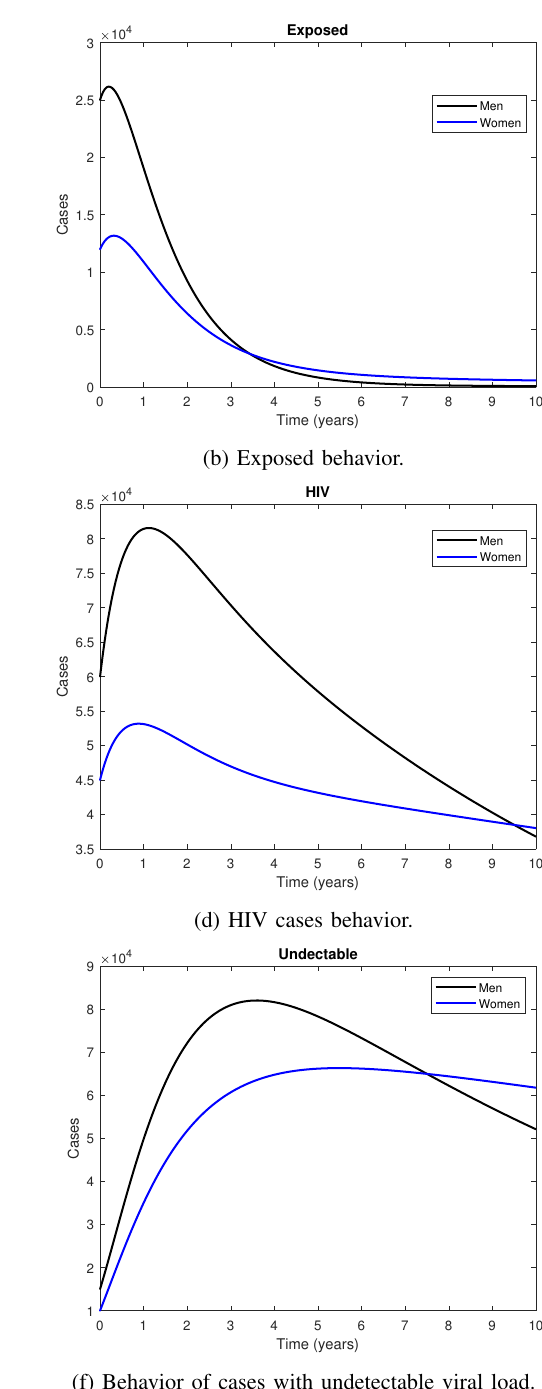
Biomath 11 (2022), 2208319,